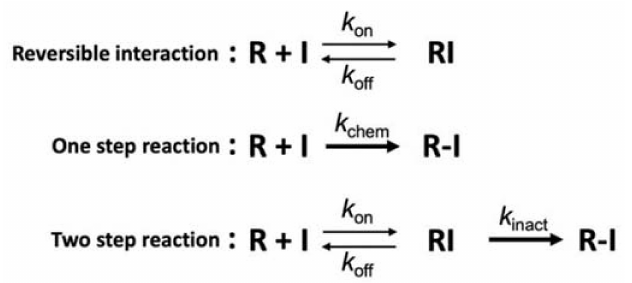
Figure 5. Mechanisms of covalent interaction [65,66]. Interaction mechanism between the protein (R) and the inhibitor (I) of non-covalent-type ( top ), conventional covalent-type including non-specific conjugation (middle) or targeted covalent-type ( bottom ). k inact and k chem are defined as the inactiva- tion rate constant for the 2-step irreversible inhibition and the reaction rate constant for the 1-step irreversible conjugation, respectively. For the TCI (bottom), first step equilibrium ( k off / k on ) is a part of the inactivation constant ( K I = [ k off + k inact ]/ k on ), which includes the TCI’s affinity and resembles the concept of the dissociation constant of a non-covalent binder (i.e., K d = k off / k on ; top). However, overall performance of the TCI is represented as a non -equilibrated parameter of k inact / K I (i.e., the inactivation